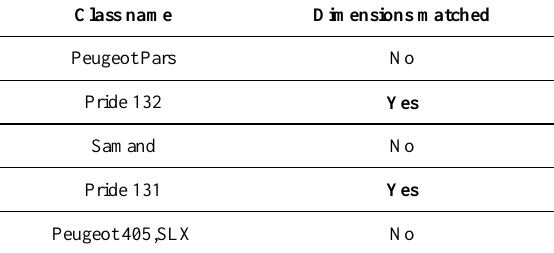
Table 2. Vehicle classification using the dimensions.